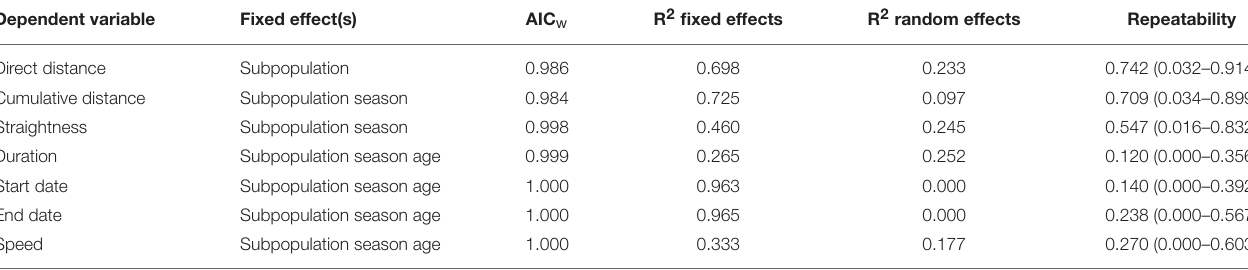
TABLE 3 | Generalized Linear Mixed Model (GLMMs) results of the most parsimonious models fitted for migration parameters of Egyptian Vultures tracked by GPS telemetry across three continents. AIC w indicates the weight of evidence for this model among eight candidate models. Dependent